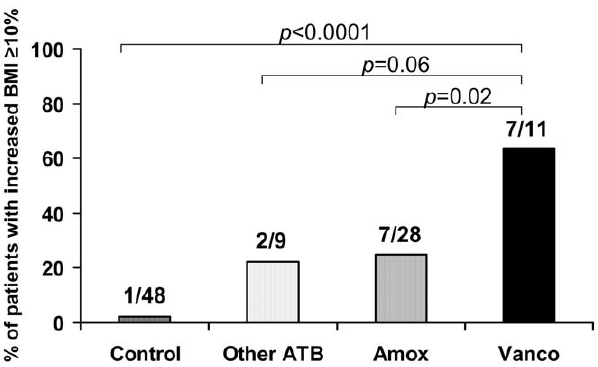
Figure 2. Percentage of patients with a major increase ( $ 10%) of body mass index (BMI), defined as an increase.